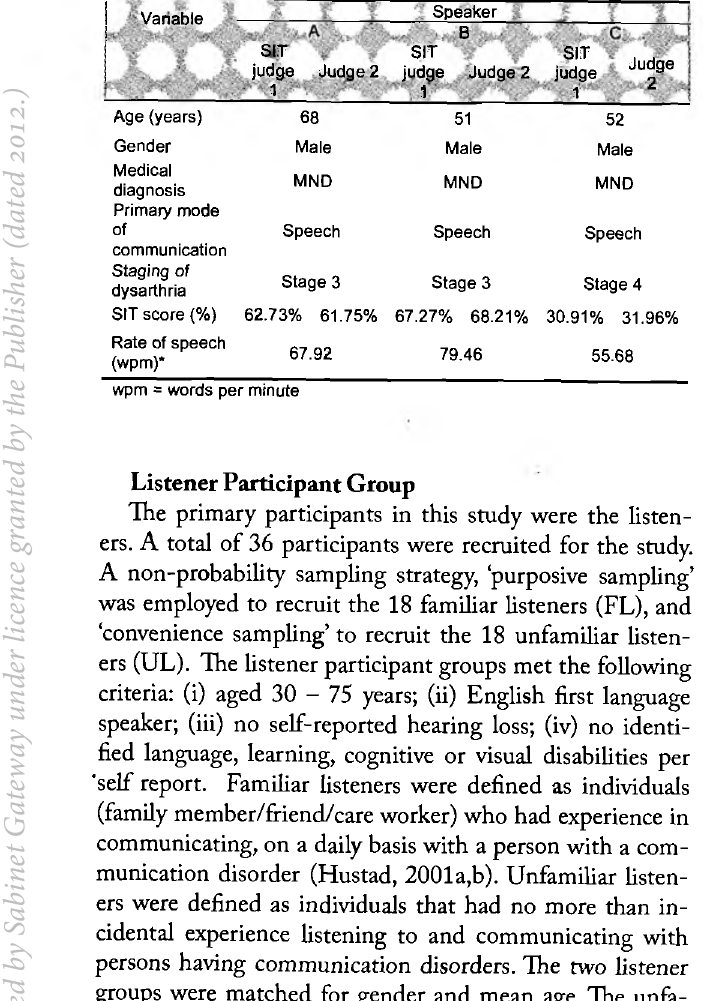
Table 1. Demographic information fo r the speakers